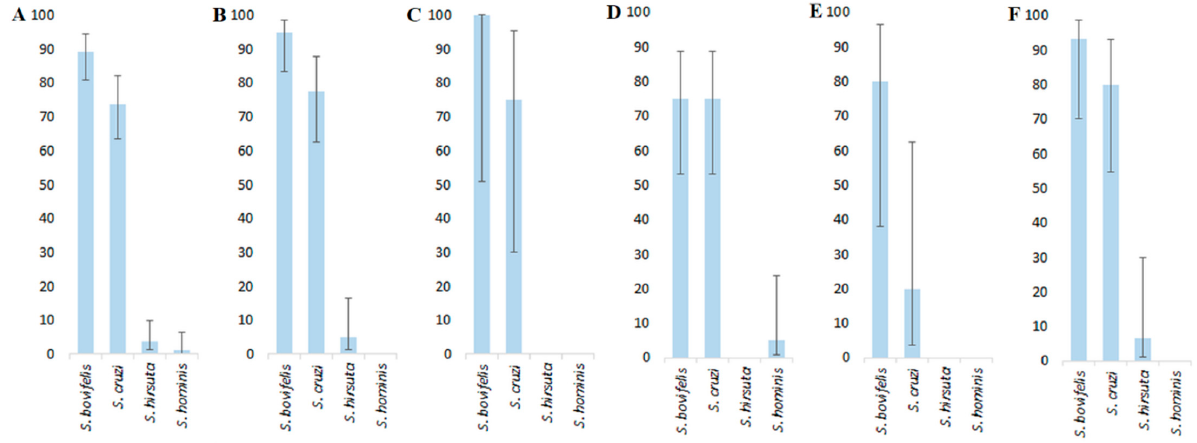
Figure 2. Prevalence of Sarcocystis spp. in the examined samples of mustelids. ( A )—in the pooled sample of all host species, ( B )—in American mink, ( C )—in Beech marten, ( D )—in European pine marten, ( E )—in European badger, ( F )—in European polecat. Differences of prevalence in A: S . bovifelis > S . cruzi ( χ 2 = 6.65, p < 0.01; Cohen’s w = 0.288), > S . hirsuta ( χ 2 = 123.32, p < 0.001; w = 2.376) and > S . hominis ( χ 2 = 130.79, p < 0.001; w = 2.688); S . cruzi > S . hirsuta (3.6%, χ 2 = 86.83, p < 0.001; w = 1.472) and > S . hominis ( χ 2 = 93.94, p < 0.001; w = 1.604); in B: S . bovifelis > S . cruzi ( χ 2 = 5.10, p < 0.025; w = 0.372); in E: S . bovifelis > S . cruzi ( χ 2 = 3.24, p < 0.075; w = 1.064).